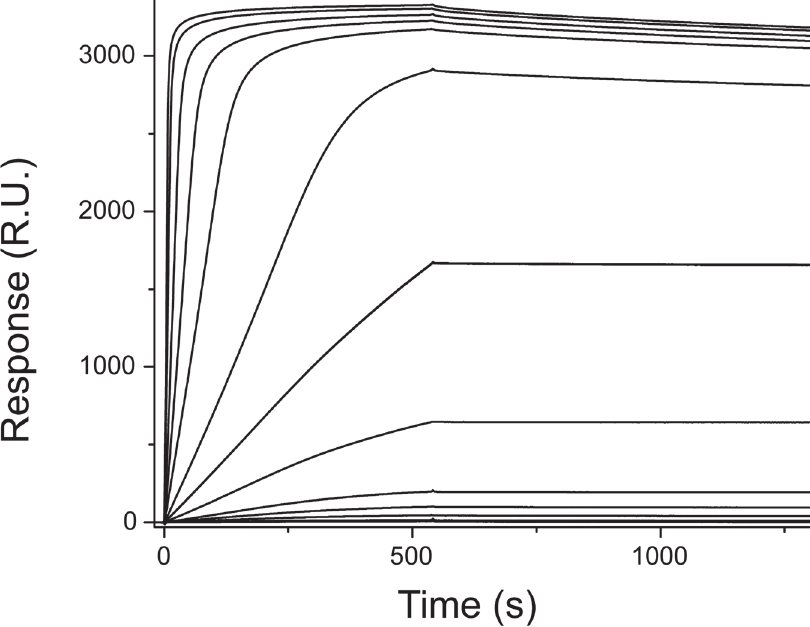
Fig 5. Interaction of GFP with a CM5 surface functionalized with GFP-Nb. Depicted sensorgrams were obtained for GFP-Nb concentration of 0.2, 0.5, 1, 2, 5, 7, 10, 15, 20, 50, 100, 200, 500, 1000 nM (from bottom to top